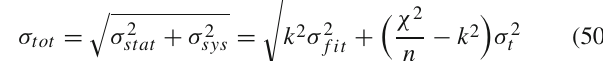
the external-layer movement, every 2 data points or 180s per knot ( m 0 = N 0 / 2 ) is enough to derive k .